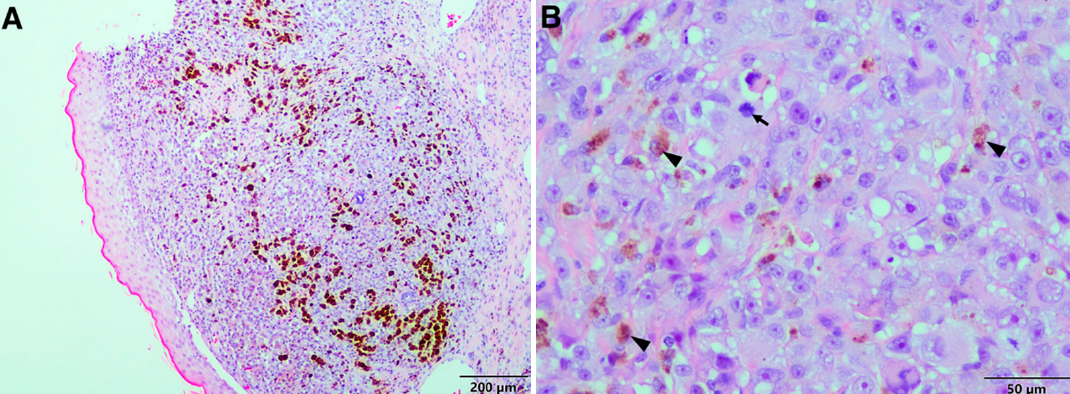
Figure 3. Malignant melanoma, lion: histopathology of the skin mass on the ear. ( A ) Proliferation of neoplastic cells in the dermis similar to those found in the liver and omentum. The neoplastic cells extend close to the epidermis and brown pigment is clearly visible. ( B ) Neoplastic cells similar to those found in the liver and omentum within the dermis containing brown cytoplasmic pigment ( arrowheads ). Note the mitotic figure ( arrow ).